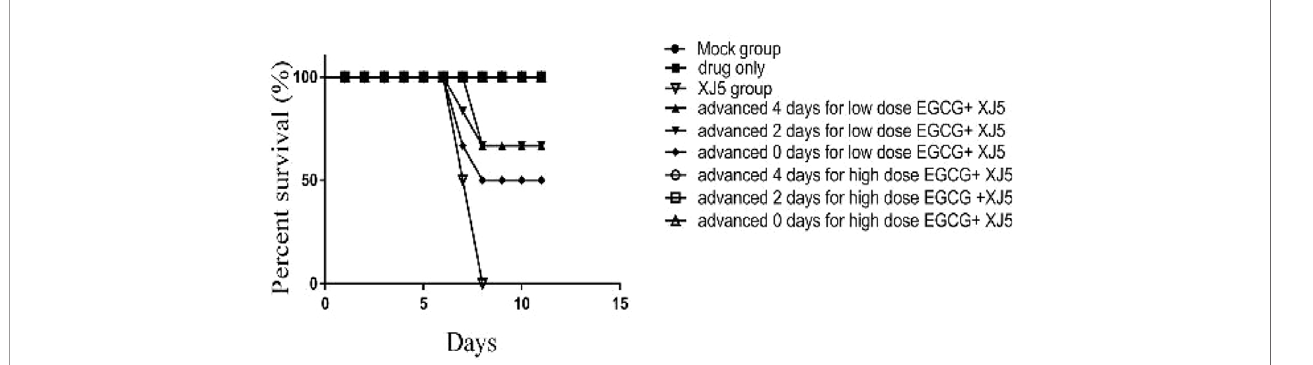
FIGURE 8 | The antiviral effect of ( – )-Epigallocatechin-3-gallate (EGCG) was evaluated in BALB/c mice divided into nine groups, control, PRV XJ5, EGCG, and EGCG+PRVXJ5 groups 20 or 40 mg/kg EGCG, injected at 4 or 2 days prior to challenge with PRV XJ5, or 1 h after challenge with PRV XJ5. The survival data for each group were